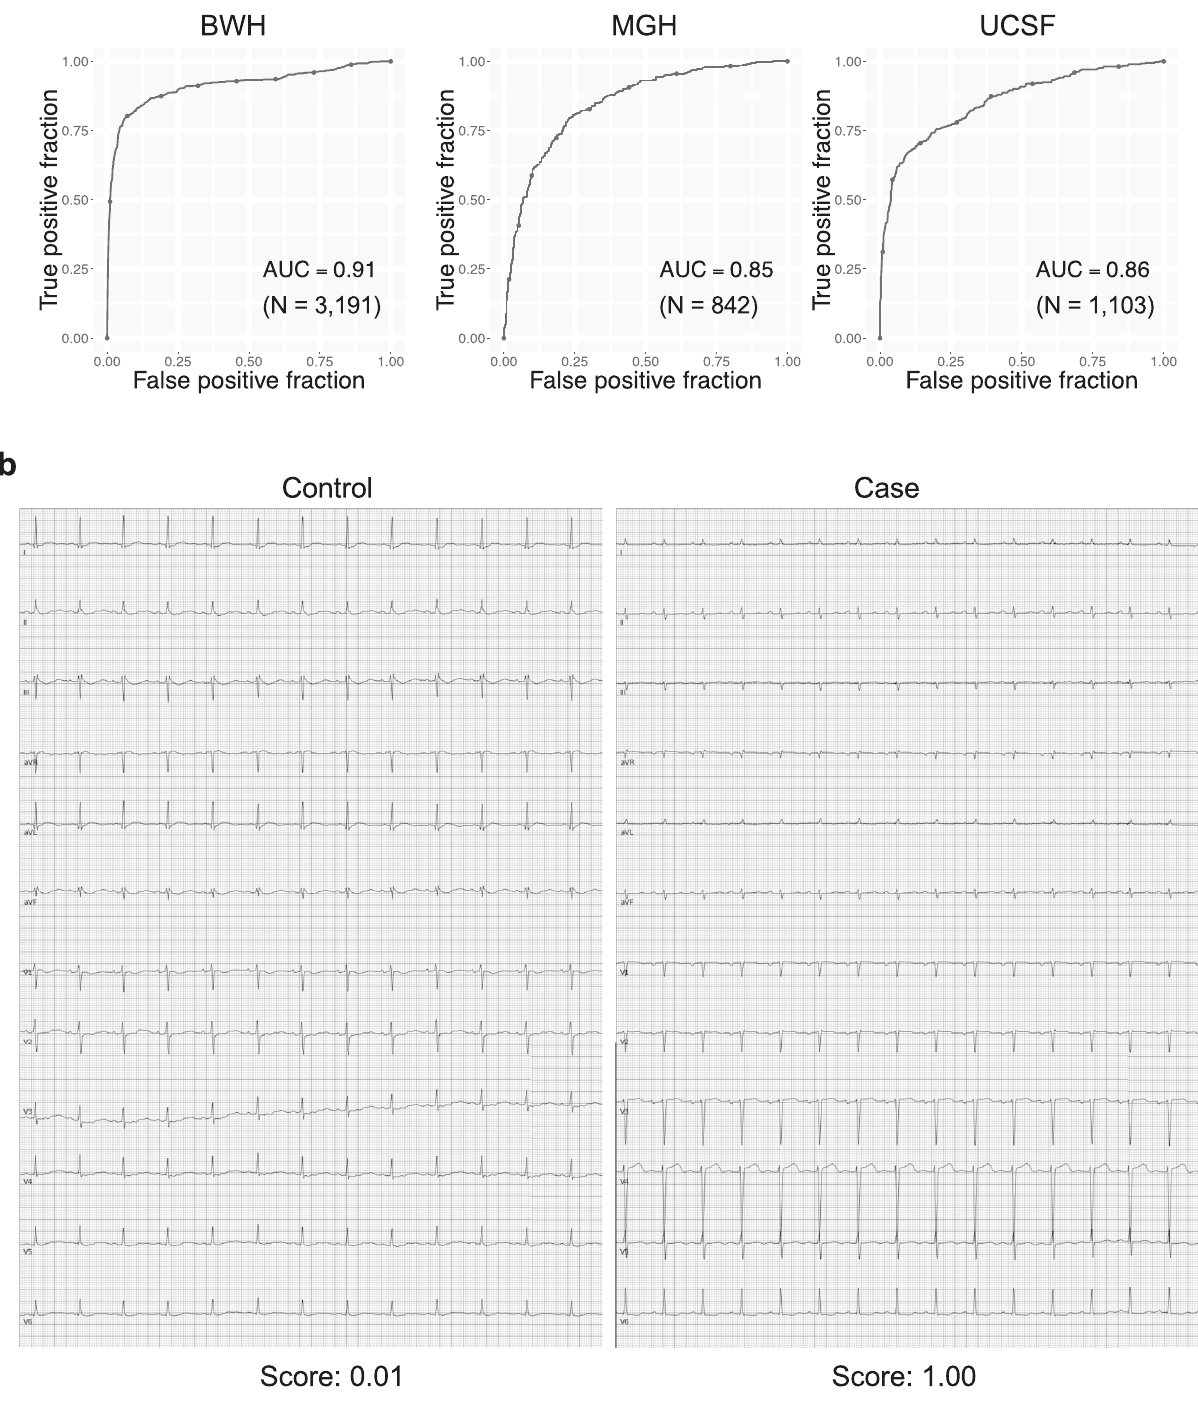
Fig. 1 Performance of the cardiac amyloidosis ECG model. a ROC plots for detecting cardiac amyloidosis for each institution. The performance on the test dataset is shown for BWH. b Representative ECG for cases and controls. The score denotes the model output for the ECG. N is the numbers of studies. Source data are provided as a Source Data fi le. BWH: Brigham and Women ’ s Hospital, MGH: Massachusetts General Hospital, UCSF: University of California San Francisco AUC: area under the curve. ECG: with recall 66.9% for MGH and PPV 33.4% with recall 67.0% for model output as gold standard, the ECG model detected cardiac UCSF at a cutoff of 0.8 (Fig. 5b). Assuming an updated prevalence amyloidosis with PPV 3.9% with recall (i.e,. sensitivity) 71.0% in after pre-screening using the ECG model, the PPV improved to MGH and PPV 3.4% with recall 52.4% in UCSF at a cutoff of 0.7 76.6% for MGH and 73.9% for UCSF with the same cutoff. The (Fig. 5a). Using the ROC curve to estimate a likelihood ratio and combined ECG-echocardiogram pipeline thus resulted in an the above estimated prevalence numbers, the echocardiography overall recall of 47.5 and 34.8% for MGH and UCSF, respectively, model alone detected cardiac amyloidosis with a PPV of 32.7%